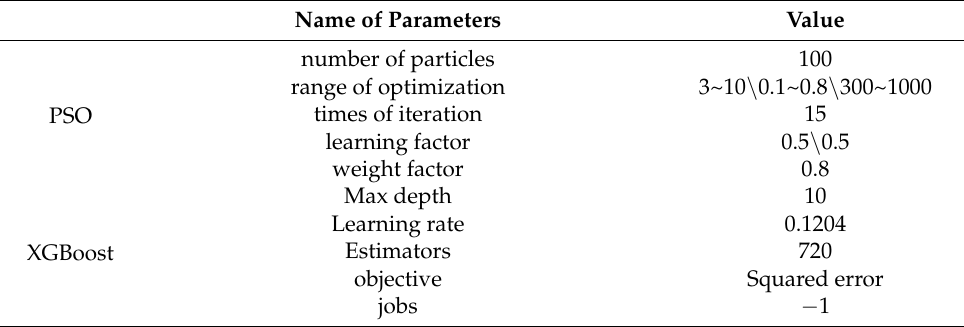
Table 4. Performance prediction model of centrifugal pump based on XGBoost.